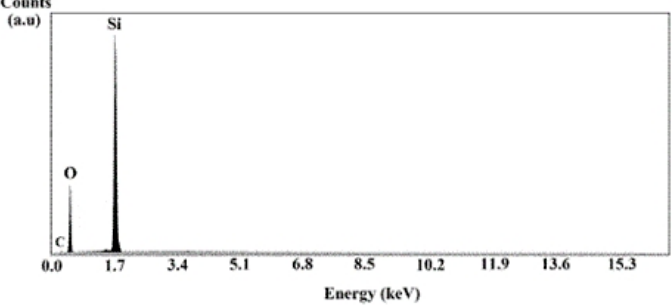
Figure 6. The EDS analysis of the SiO 2 aggregate without heat treatment.